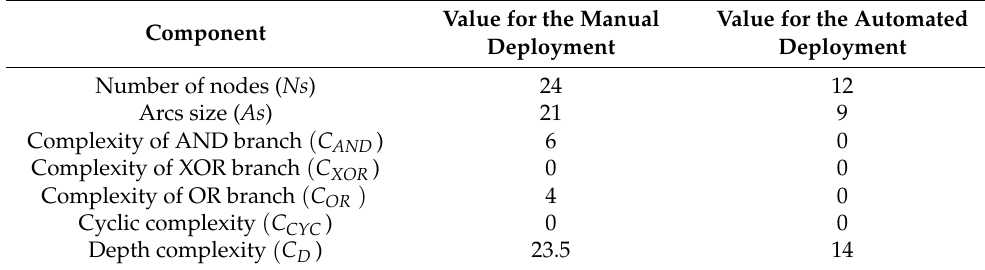
Table 6. Parameter values for Yaqin complexity of the two deployment processes. Value for the Manual Value for the Automated Parameter Deployment Deployment Starts size ( Ss ) 1 Intermediates size ( Is ) 0